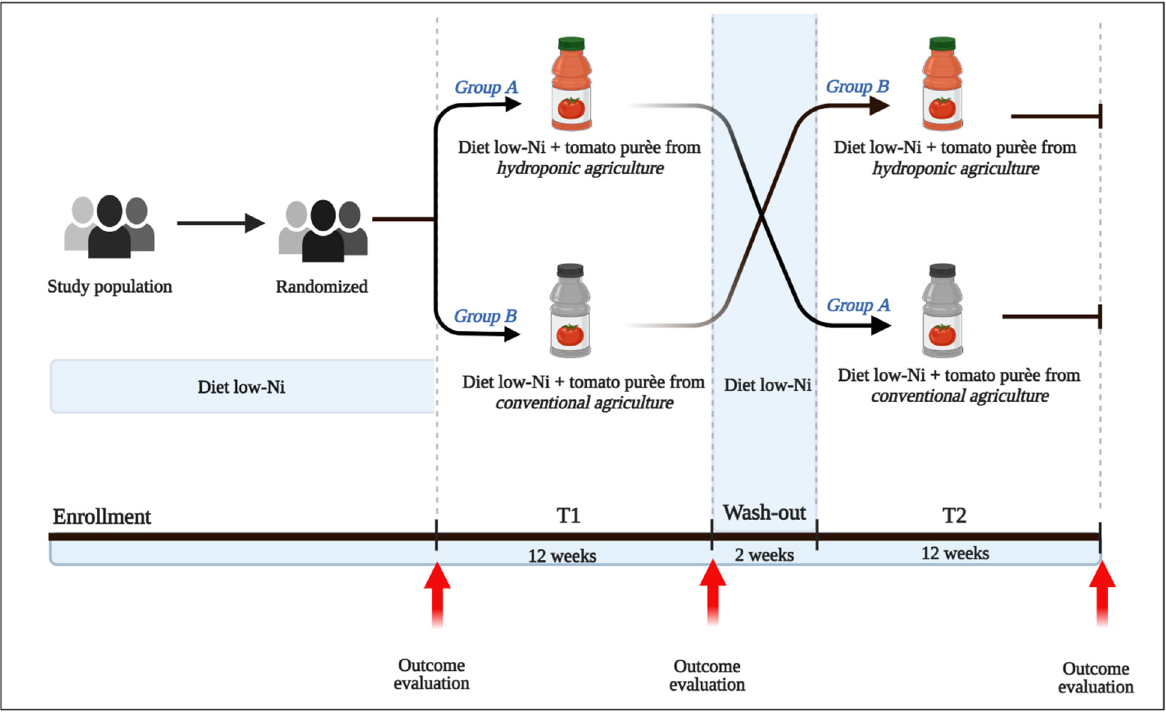
Figure 1. Datterino trial: study design.